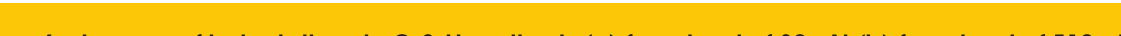
Figure 6 – Images of indentations in C-S-H synthesis (a) for a load of 32mN (b) for a load of